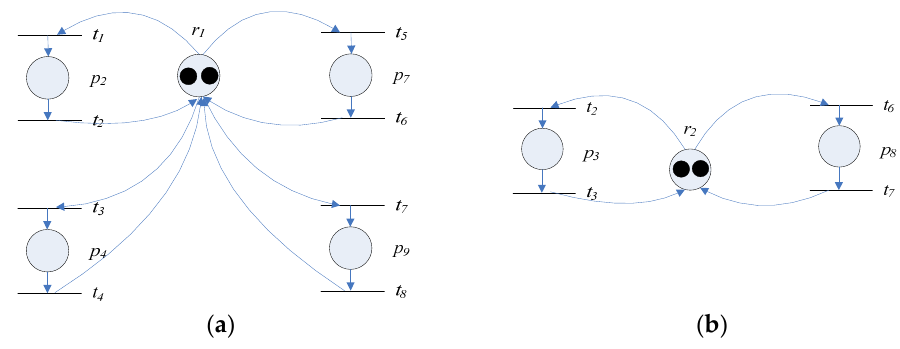
=∈ r , where r ∈ R = { r 1 , r 2 } : ( a ) GR r 1 ( b ) GR r 2 .